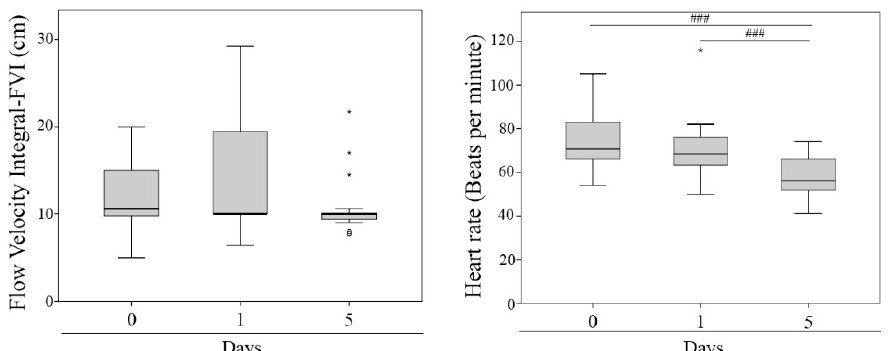
Table 4. Effect of ejaculate fraction (F1, F2, or F3) on Doppler ultrasonography values of the uterine arteries blood flow. Data include the statistical analysis of repeated measures (D0, D1, and D5). Data are shown as the mean ± SEM.